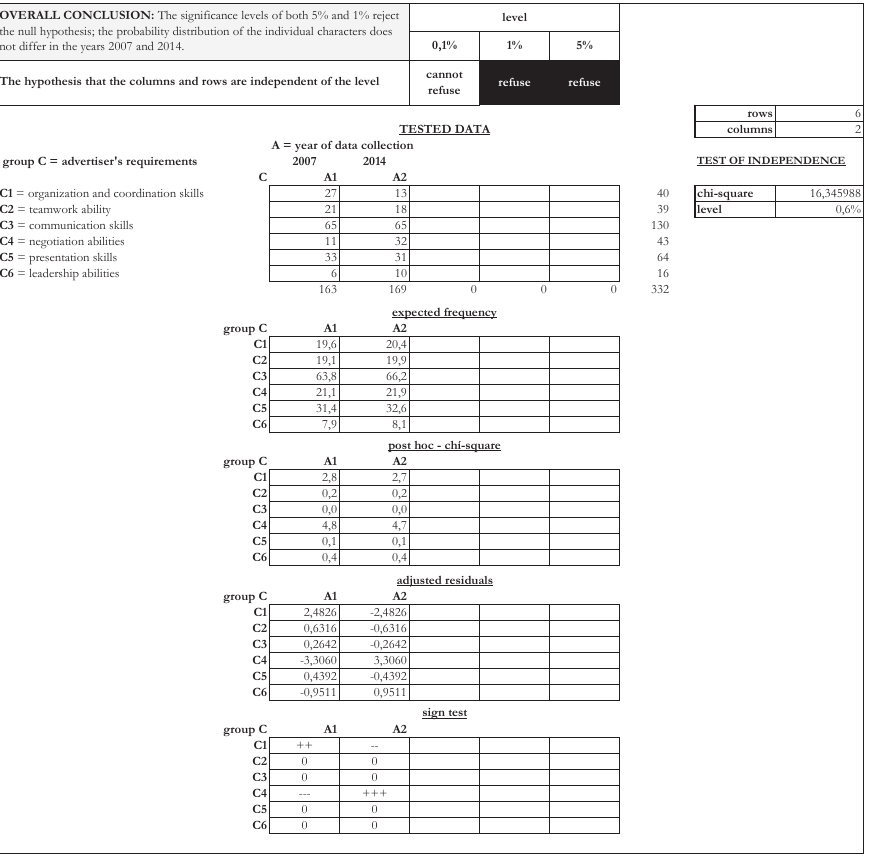
Tab. 2 - Two-dimensional analysis for a group of psychological requirements. Source: Inde- pendent